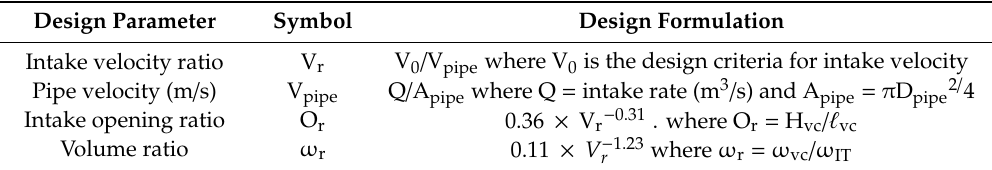
Table 4. Engineering design criteria for seawater intake